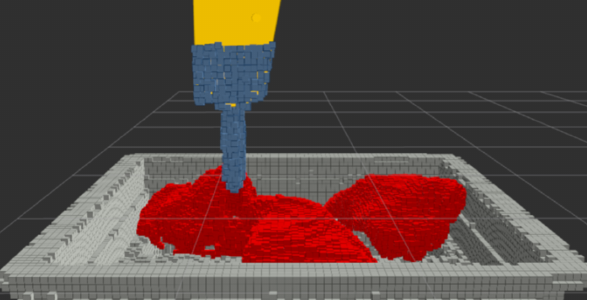
Figure 13. The 3D LIDAR scanning at the dumping point of the underground mine for tele-operation of hydraulic hammer (Correa et al.